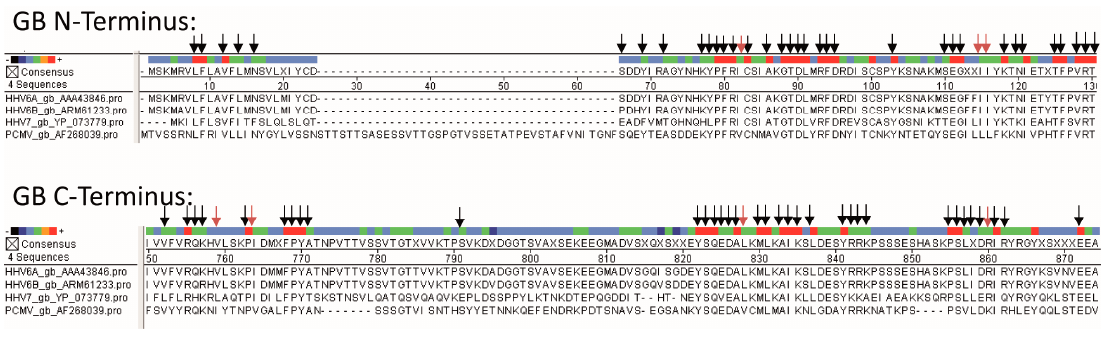
Figure 3. Multiple alignment of protein sequences of gB of PCMV, HHV-6A, HHV-6B, and HHV-7. gB N-terminus, N-terminal part of gB of PCMV corresponding to R1, gB C-terminus, C-terminal part of gB of PCMV, corresponding to R2. The accession numbers are indicated. Dots represent missing amino acids and deletions. Arrows indicate related amino acids between PCMV and HHV-6A (black arrows, identical amino acids; red arrows, conserved amino acids, R=K, L=I=V, F=Y).